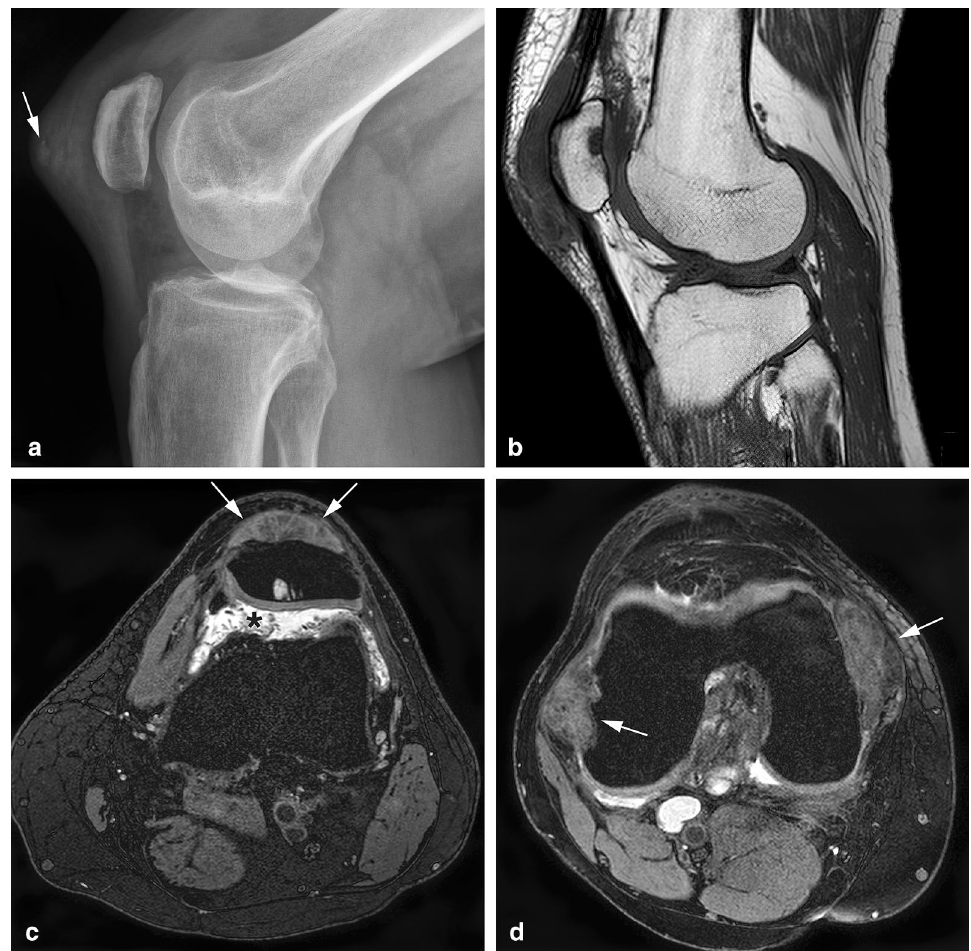
Fig. 4 Differential diagnosis: gout in the knee. a Lateral radiograph demonstrates marked pre-patellar soft tissue swelling containing increased density and several ill-defined calcifications (arrow). b Sagittal T1 shows a prepatellar, low signal intensity oval shaped soft tissue mass and a subchondral cyst in the patella. c Axial T2 FS confirms the prepatellar, low signal intensity mass invading the quadriceps tendon (arrows) and shows joint effusion containing multiple small synovial proliferations in the suprapatellar recess (asterisk). Aspiration of joint fluid with crystals confirmed the diagnosis of gout. d Axial T2 FS demonstrates low signal intensity soft tissue lesions in keeping with gout tophi deep to the collateral ligaments, causing erosion of the medial and lateral femoral condyles